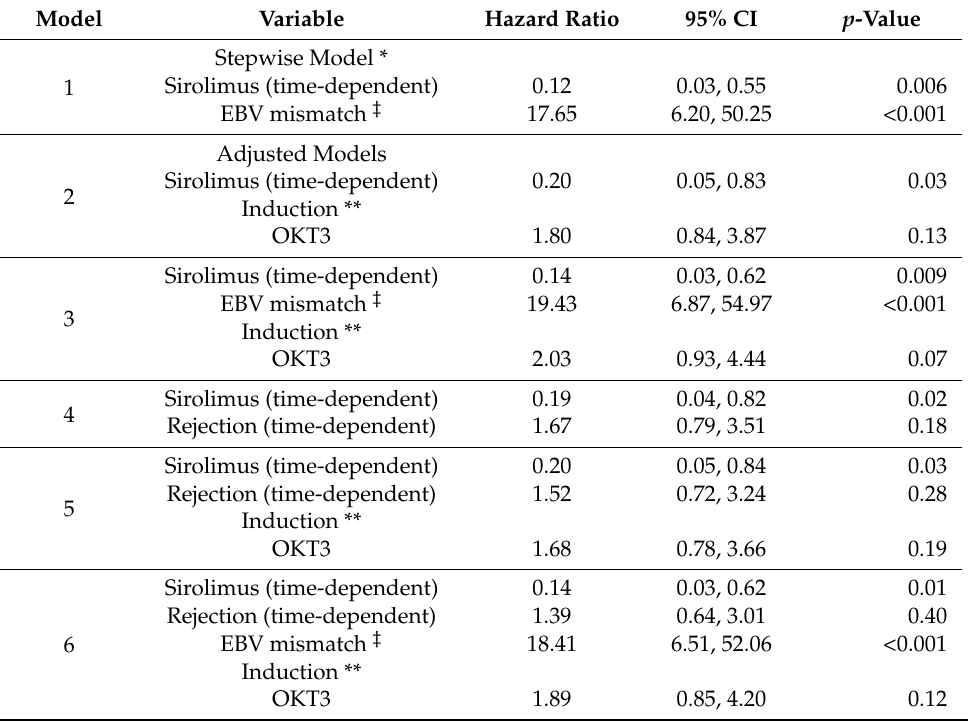
Table 3. Multivariable models for association with increased hazard of PTLD.